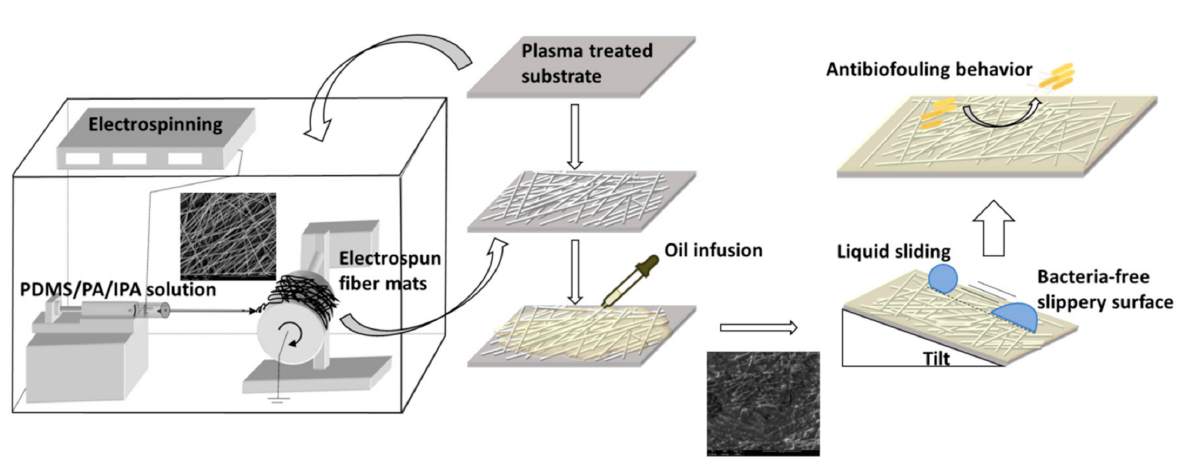
Figure 1. Electrospinning and oil infusion procedures on PE and PU